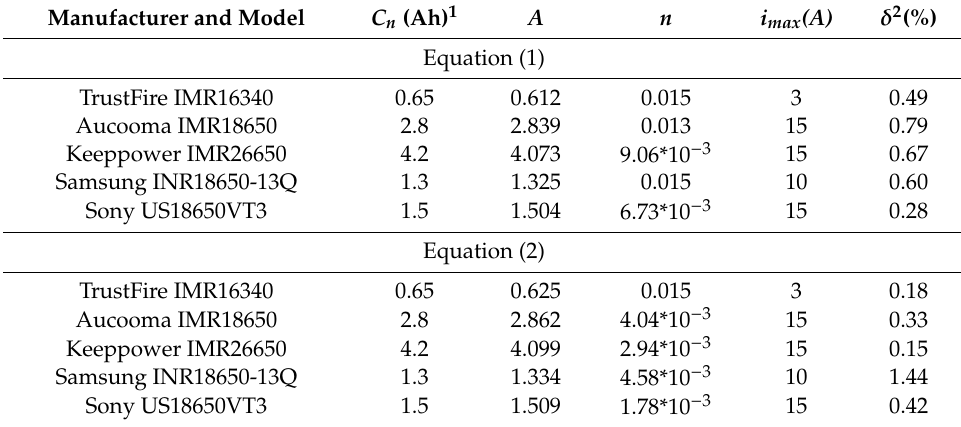
Table 4. Optimal parameters of Equations (1) and (2) for lithium-ion cells at small currents, in the range of experimental discharge currents from 0.2Cn to